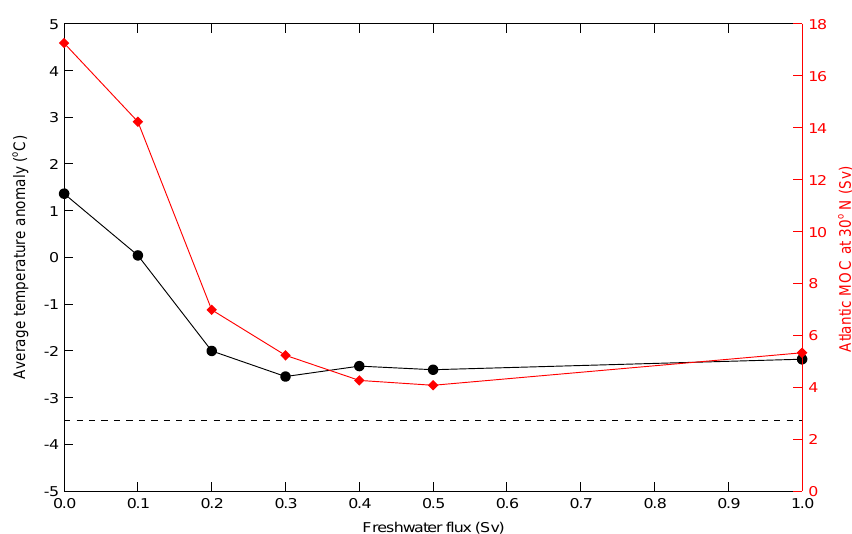
Figure 9. Response of the North Atlantic summer SSTs and strength of the overturning circulation to varying amounts of freshwater input injected between 50 and 70 ◦ N (0, 0.1, 0.2, 0.3, 0.4, 0.5, and 1Sv). Left axis: average 50-year model temperature anomaly relative to the present day. The temperature is averaged over all model grid boxes where data points are located. Right axis: 50-year average maximum Atlantic Meridional Overturning Circulation strength at 30 ◦ N. The dashed horizontal line corresponds to the average summer (July, August, September) temperature anomaly for all marine data located at >40 ◦ N for the 130ka time slice (Capron et al., 2014).